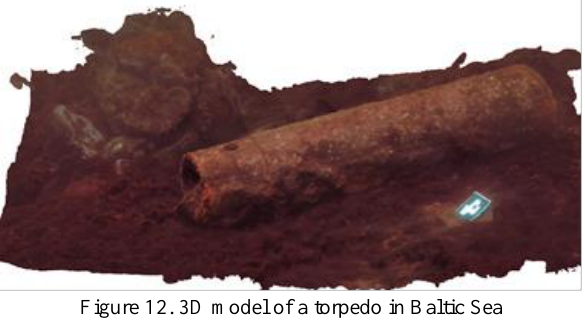
Figure 12. 3D model of a torpedo in Baltic